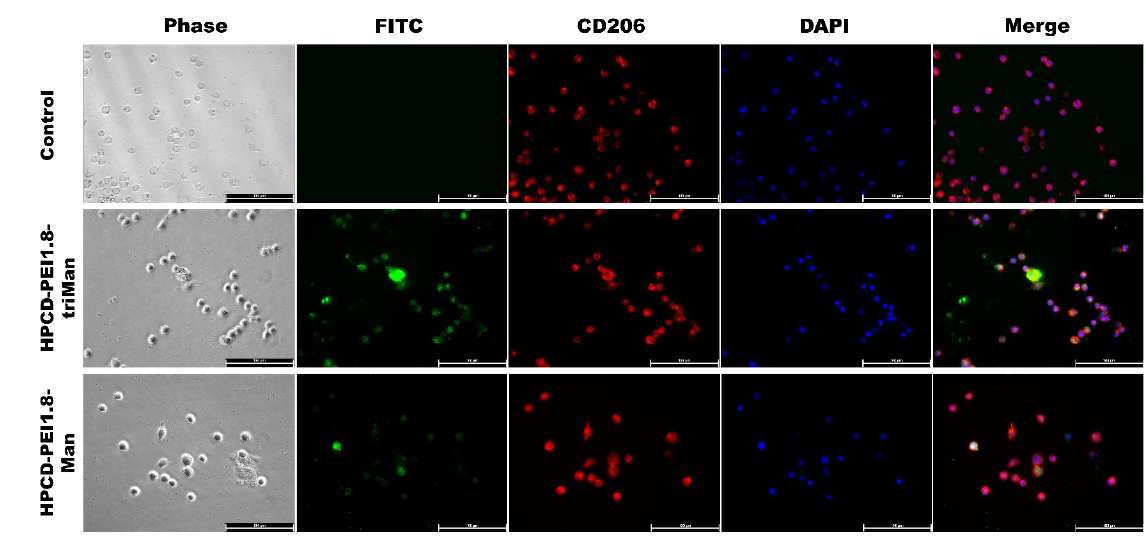
Figure 9. Immunocytochemical evaluation of CD206 in THP-1-derived macrophage-like cells (red channel). Phagocytosis assay with HPCD-PEI1.8-triMan and HPCD-PEI1.8-Man conjugated with a FITC fluorescent label after incubation for 40 min (green channel). Phase contrast microscopy, fluorescent microscopy, blue channel—nuclei stained with DAPI. Scale bar, 100 µ m.